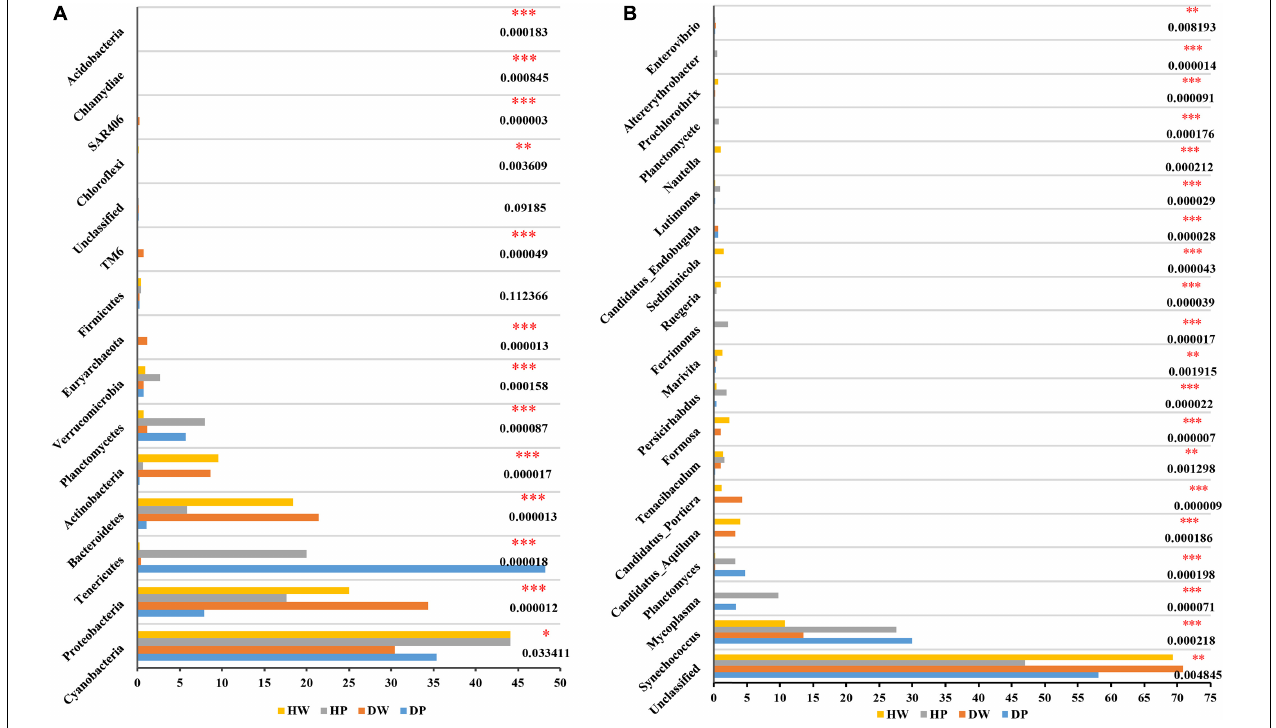
Candidatus_Endobugula